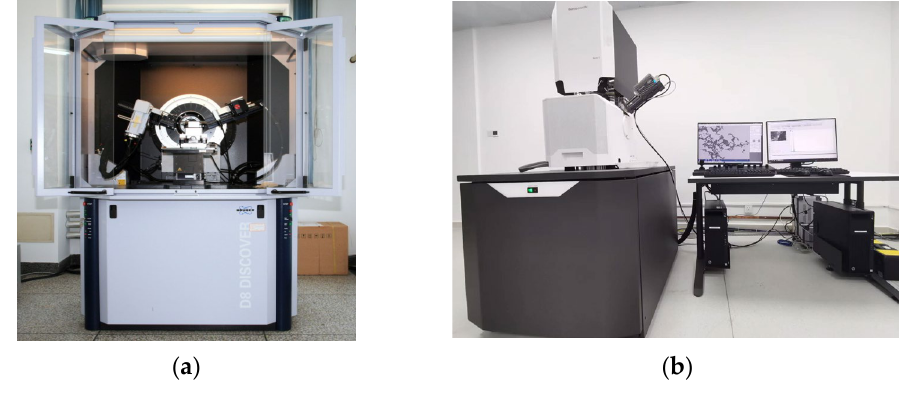
Figure 2. The experiment site. ( a ) X-Ray diffraction; ( b ) SEM.